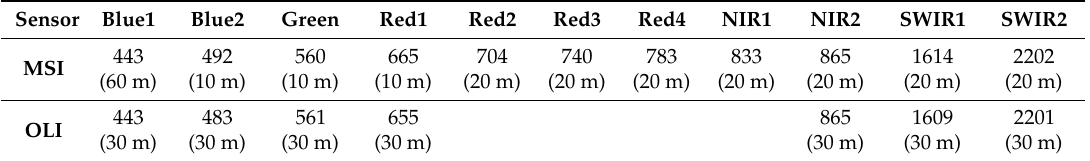
Table 2. Central band wavelengths (nm) for the bands of the MSI and OLI sensors used in this work. Numbers in brackets represent the band spatial resolution (m). The panchromatic and cirrus bands of OLI and the cirrus and vapor bands of MSI were not considered. Near Infrared (NIR) and Shortwave Infrared (SWIR) bands are also indicated.